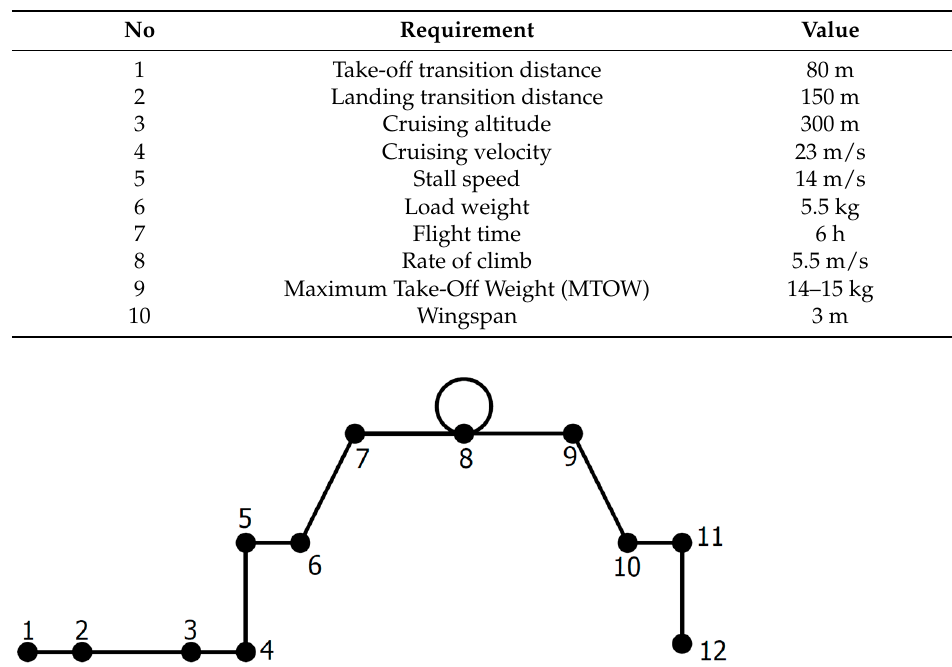
Figure 1. Mission Profile VTOL-Plane Surveillance. Note: 1—Ground test; 2—Engine start and warm-up; 3—VTOL take-off preparation; 4—VTOL take-off; 5—VTOL transition to Fixed-wing; 6—Climb; 7—Cruise; 8—Loiter and cruise back; 9—Descent; 10—Fixed-wing transition to VTOL; 11—VTOL landing; 12—Engine shutdown and ground test.